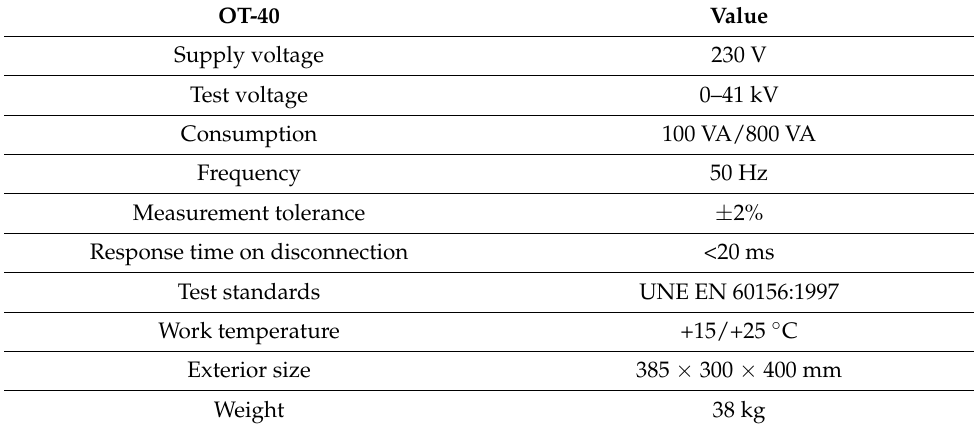
Figure 20. Oil testing device with oil sample.